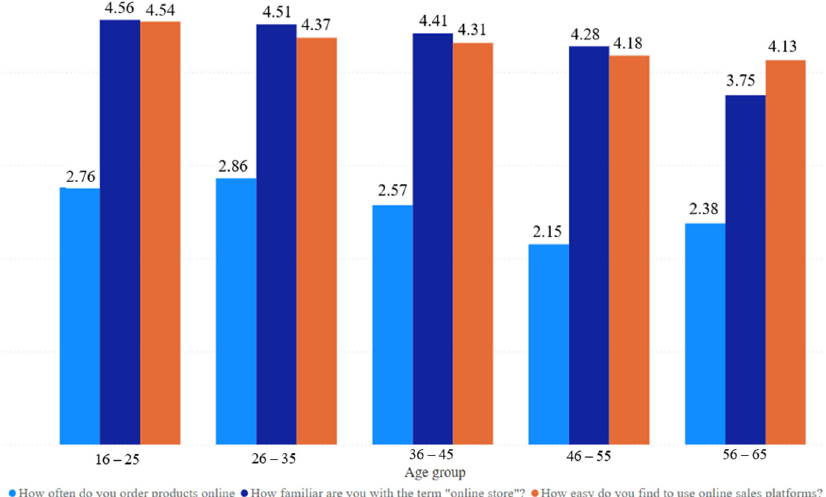
Figure 3. The frequency of online shopping by age groups (Source: Data according to the answers of the applied questionnaire).